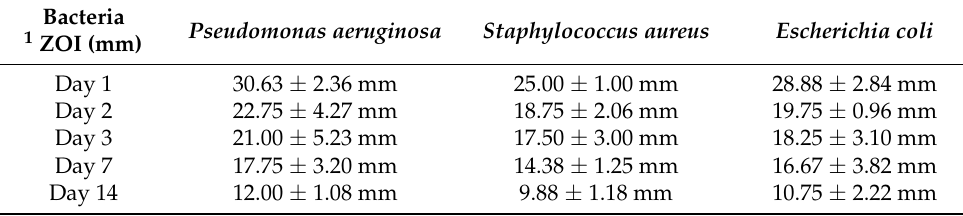
Table 3. Measurements (in mm) of the zones of inhibition with bone cements containing